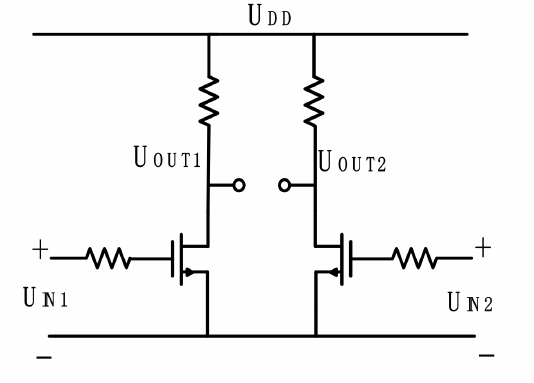
Figure 20. Differential amplifier circuit schematic diagram.